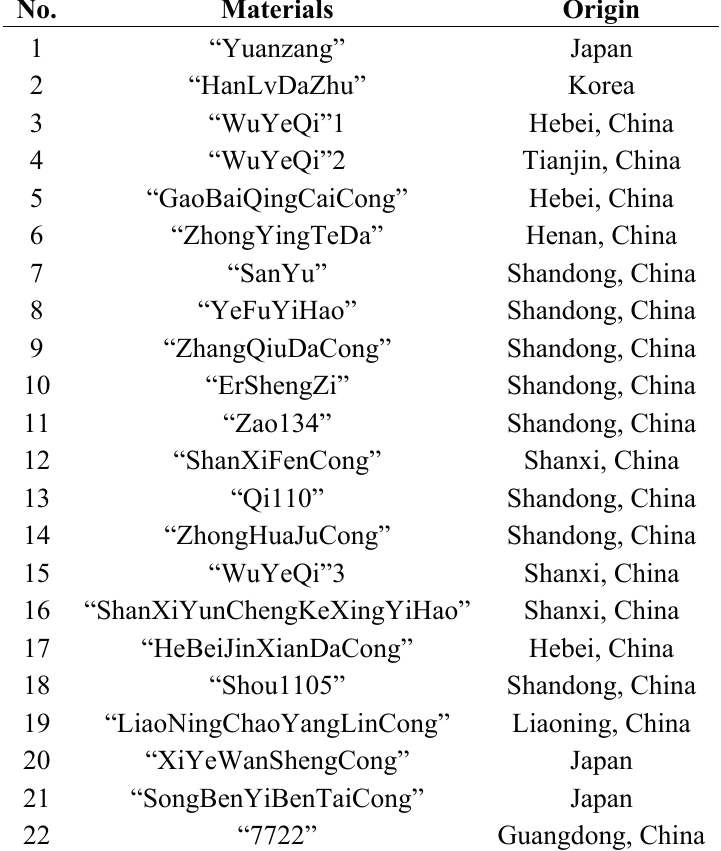
Table 3. List of 22 Allium accessions used in the polymorphism analysis.